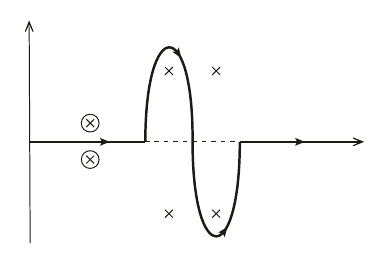
Figure 27 . Poles of (cid:27) + and (cid:28) (cid:0) .